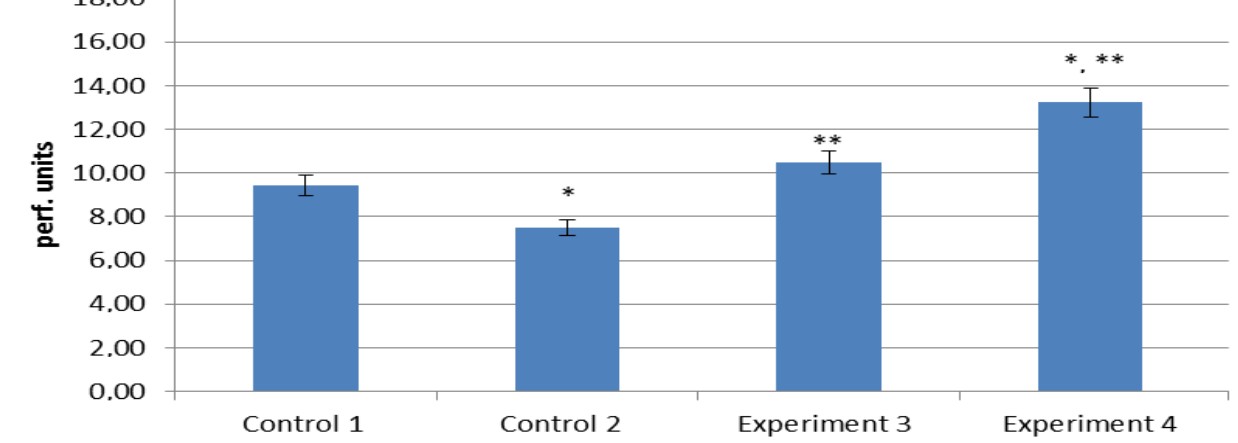
Figure 1. The level of the microcirculation indicator (MI) in the experimental treatment of thermal trauma. *—differences are statistically significant compared to intact rats ( p < 0.05); **—differences are statistically significant compared to CThB controls ( p < 0.05).